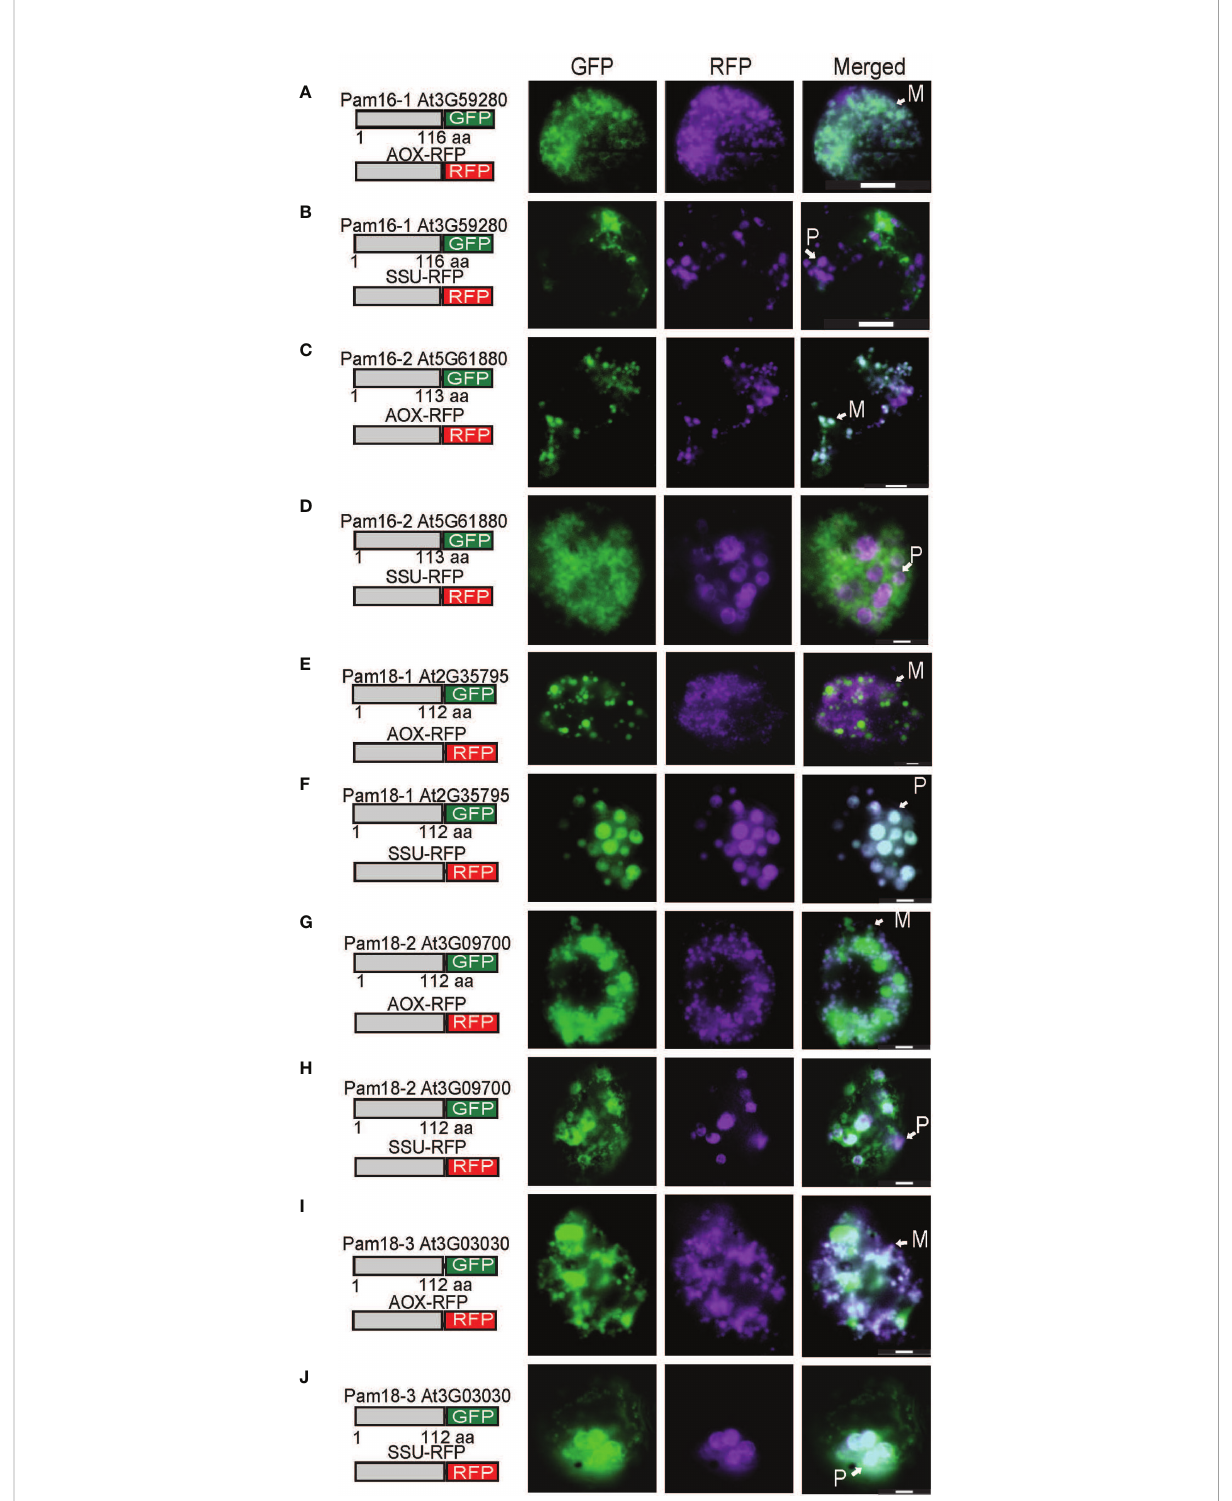
FIGURE 2 Biolistic transformation and localisation assays of Arabidopsis Pam16 and Pam18 GFP. C-terminal GFP fusions transformed into Arabidopsis cell suspensions alongside a mitochondrial targeted RFP (AOX-RFP) or plastid targeted RFP (SSU-RFP). Scale bar indicates 20 m m. M, mitochondria; P, plastid. Pam16-1 (A, B) . Pam16-2 (C, D) . Pam18-1 (E, F) . Pam18-2 (G, H) . Pam18-3 (I, J)